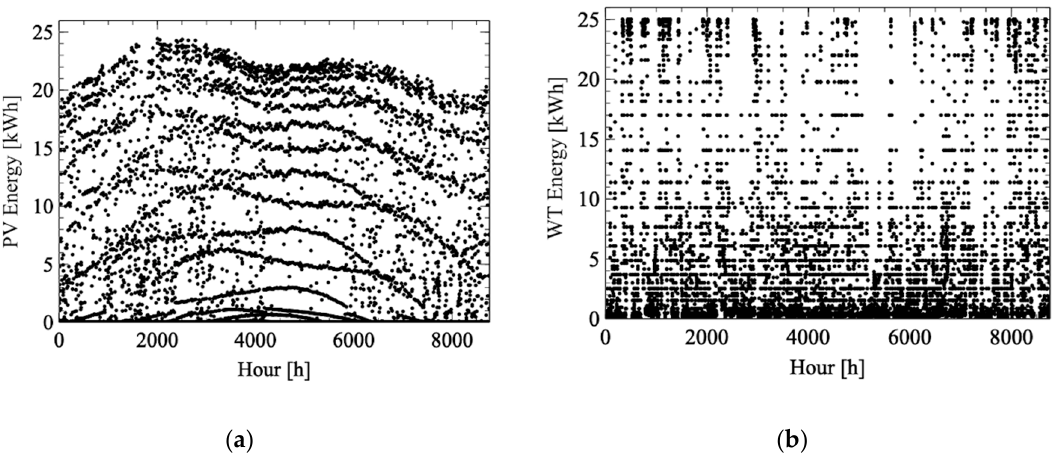
Figure 9. Energy production of the photovoltaic and wind turbine subsystems with similar maximum power. ( a ) PV (91 modules) and ( b ) WT (nominal power = 20 kW el ).